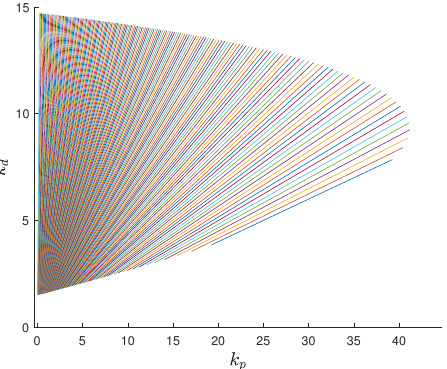
Figure 7. Feasible PD parameter region with p 1 = 1, p 2 = 0.5 and τ = 0.1. To determine how unstable poles affect the stabilizing parameter region, the stabi- lization of the plant (Equation (6)) with p 1 = 1, p 2 = 2 and τ = 0.1 under PD control is investigated. Figure 8 indicates that the region will be reduced with respect to the case of p 2 = 0.5 (Figure